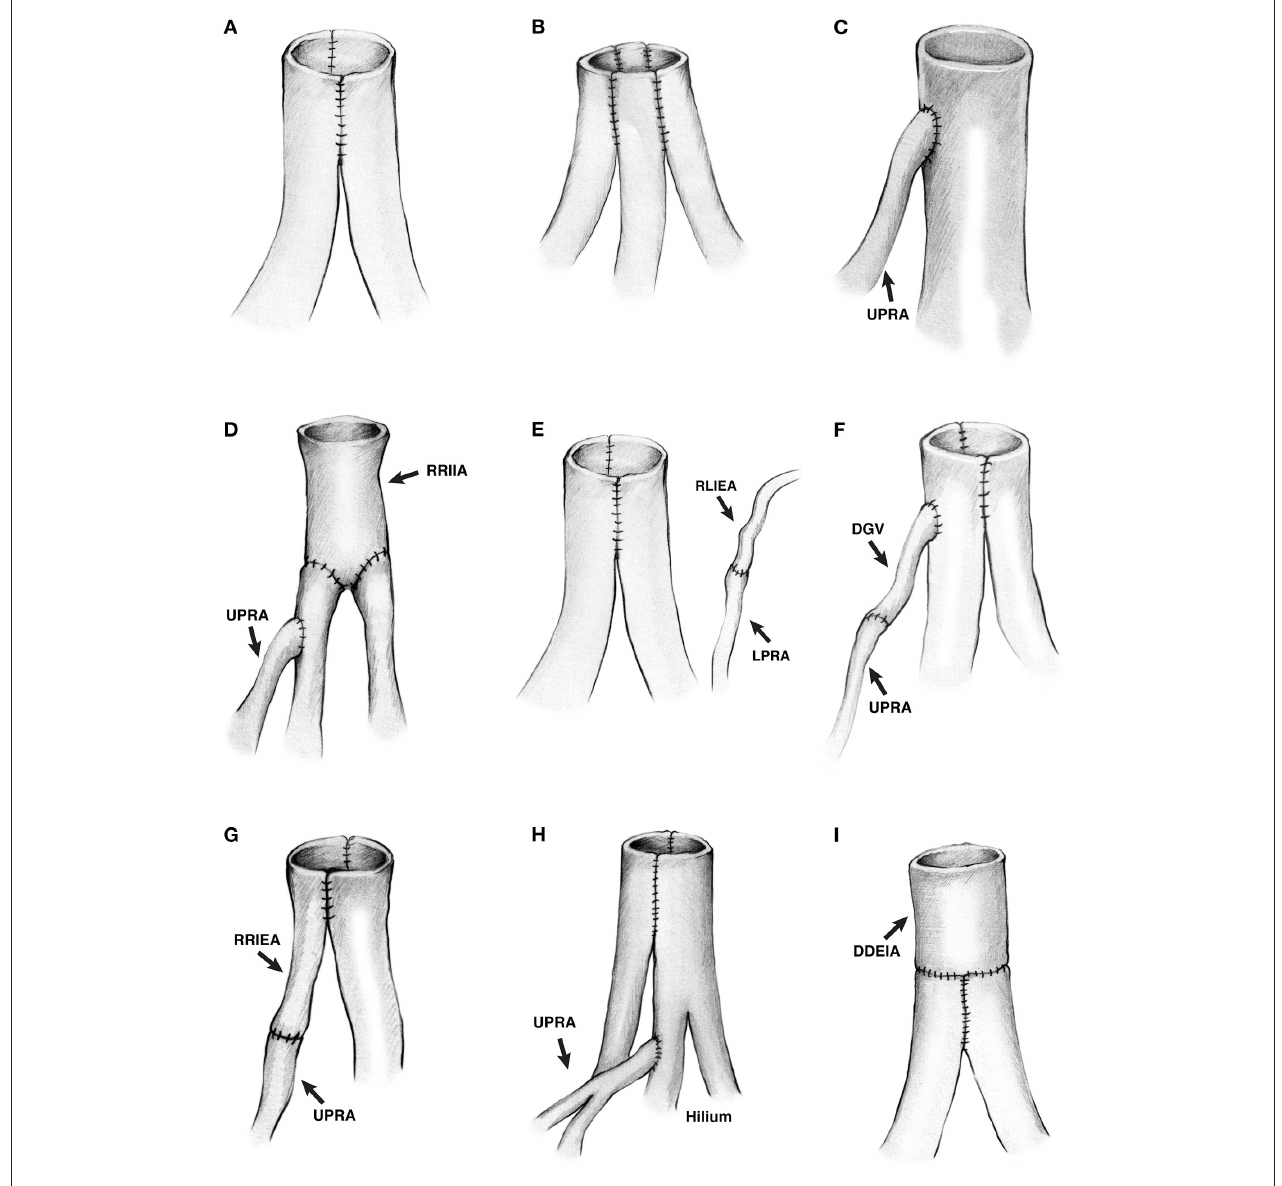
FIGURE 2 | (A–H) Drawing of the different living donor renal artery reconstructions. (A) Two renal arteries conjoined side-to-side. (B) Three renal arteries conjoined side-to-side. (C) A small upper pole renal artery anastomosed end-to-side into the major renal artery. (D) A segment of recipient right internal iliac artery was anastomosed end-to-end to two renal arteries, and a small upper pole renal artery was anastomosed end-to-side into the upper renal artery. (E) Two renal arteries conjoined side-to-side, and a lower pole renal artery was anastomosed end-to-end to the recipient’s left inferior epigastric artery. (F) Two renal arteries conjoined side-to-side, and an upper pole renal artery was anastomosed end-to-side into the upper major renal artery using the donor gonadal vein as an interposition graft to increase the length of the upper pole renal artery. (G) An upper pole renal artery was anastomosed side-to-side to the renal artery using a recipient right inferior epigastric artery as interposition graft to increase the length of the branch. (H) Two renal arteries conjoined side-to-side, and a short upper pole renal artery was anastomosed end-to-side into one of the branches of the upper renal artery. The anastomosed was inside the hilum. (I) Two renal arteries conjoined side-to-side, then anastomosed end-to-end to a deceased donor external iliac artery to increase the length. Both renal arteries were short. UPRA indicates upper pole renal artery; RRIIA, right recipient internal iliac artery; LPRA, lower pole renal artery; RLIEA, recipient left inferior epigastric artery; DGV, donor gonadal vein, RRIEA, recipient right inferior epigastric artery; DDEIA, deceased donor external iliac